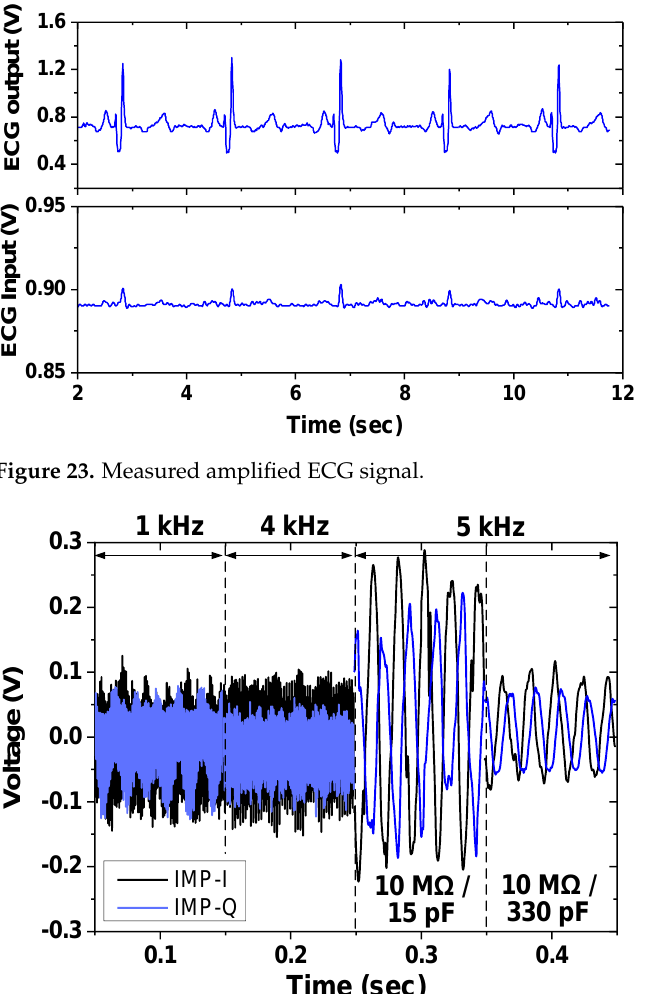
Figure 24. Measured result of the impedance channel. The current driver injects input at three frequencies (1 kHz, 4 kHz, and 5 kHz). The demodulation is performed at 5 kHz.